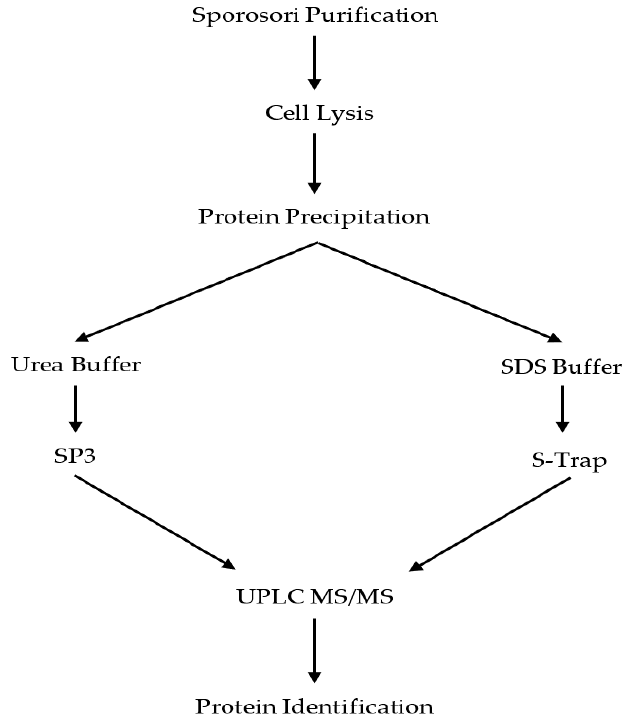
Figure 6. Workflow for the sample preparation optimisation experiments. Proteins from S. subterranea sporosori were prepared by the SP3 method or the S-Trap filters and analysed by an MS-based approach. SDS: sodium dodecyl sulphate, UPLC: ultra-performance liquid chromatography.